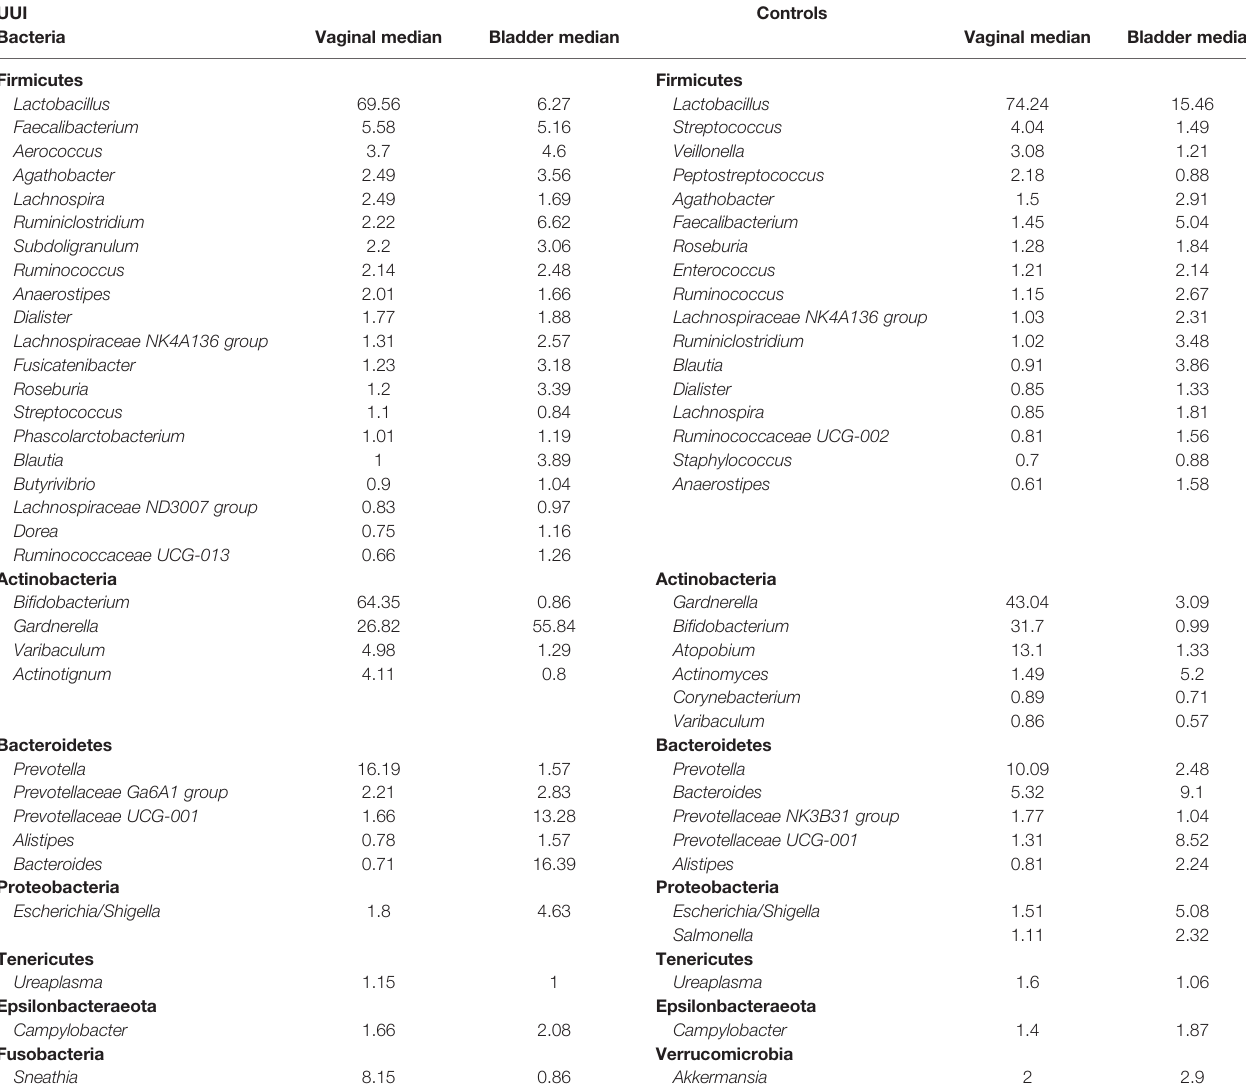
TABLE 9 | Bacteriashared across vaginaland bladder microbialcommunities in women with UUI and Controls, ranked by median abundance inthe vaginal community. UUI Controls Bacteria Vaginal median Bladder median Vaginal median Bladder median